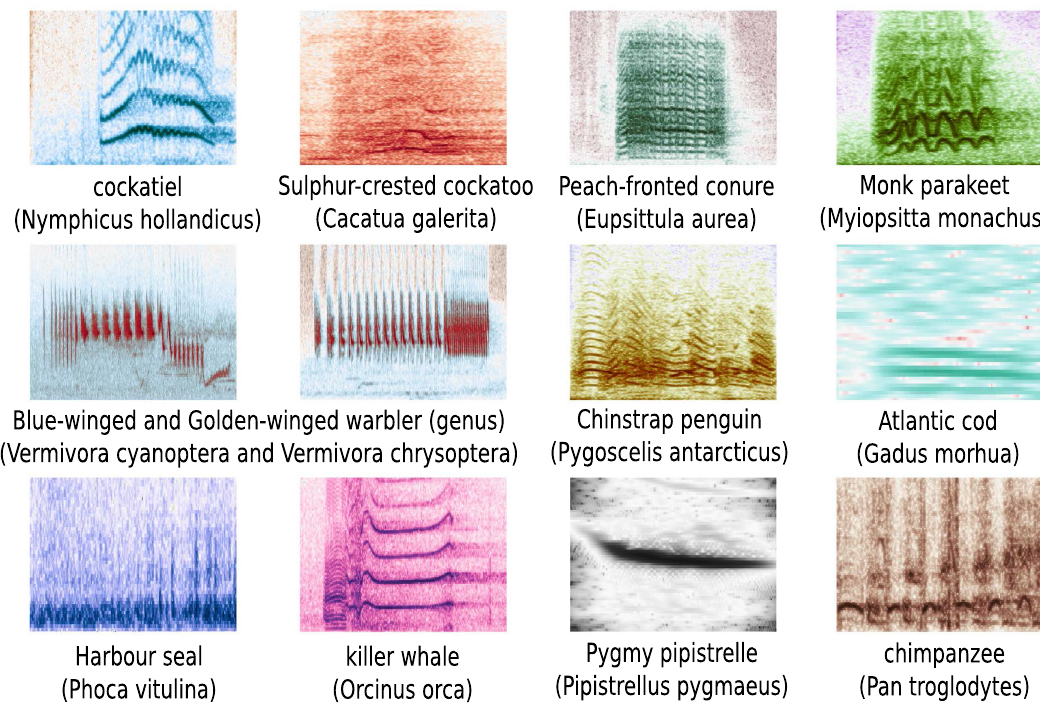
Figure 1. Animal-specific data (10 different species, 1 additional genus) utilized to investigate the ANIMAL- SPOT framework (created via Inkscape 39 , Version